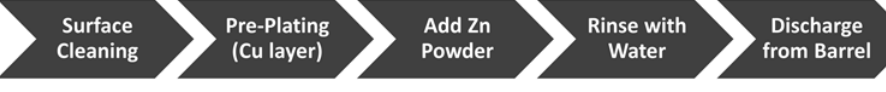
Figure 1. Mechanical plating procedure.